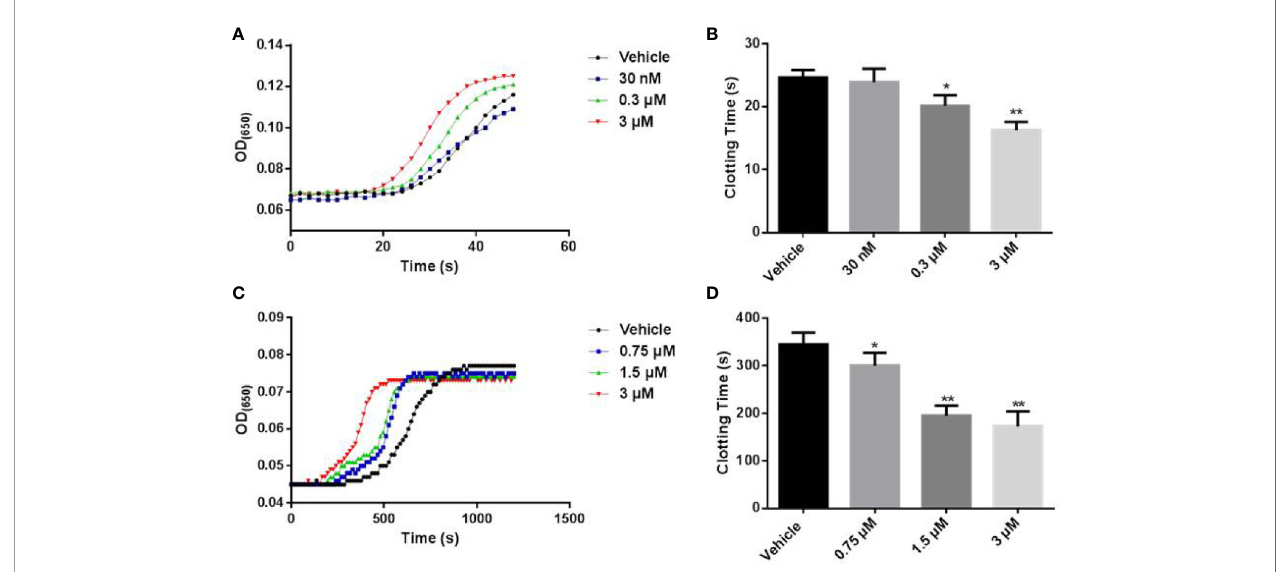
FIGURE 2 | The effect of LCTX-F2 on coagulation. (A) The effect of LCTX-F2 on APTT. LCTX-F2 was incubated with APTT reagent (50 m l) at 37°C for 3 min. (B) Histogram of APTT levels. (C) The effect of LCTX-F2 on recalci fi cation time. (D) Histogram of recalci fi cation time with different doses of LCTX-F2. Data are presented as means ± SD of three independent experiments. * P < 0.05, ** P < 0.01 compared with vehicle as determined by the two-sample Student ’ s t